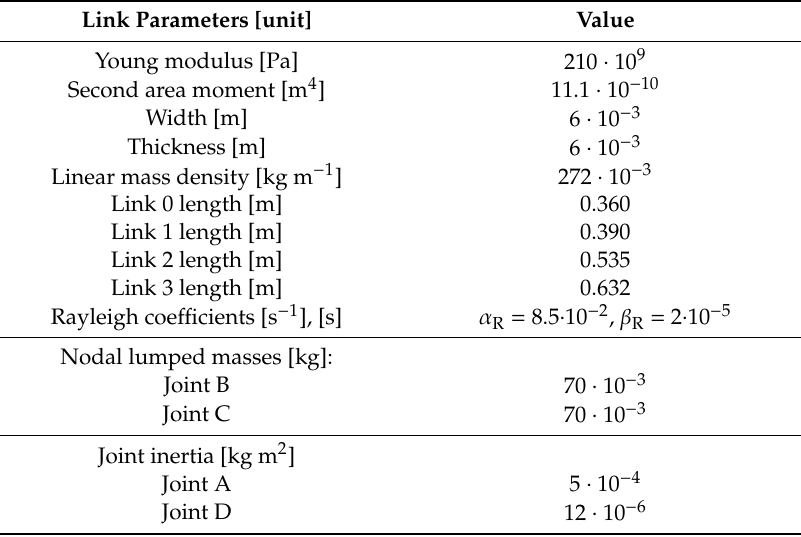
Table 9. Open-loop and closed-loop poles for the test-case 4.